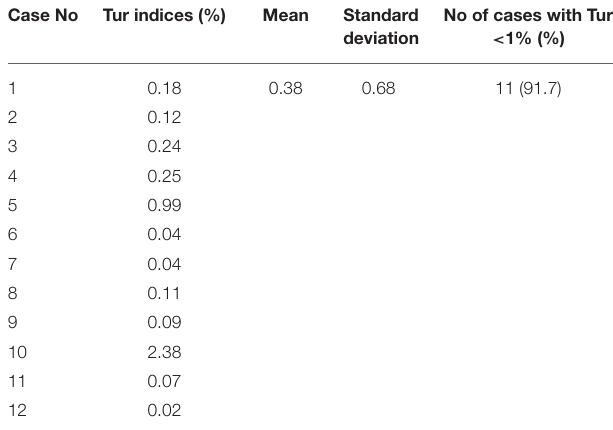
TABLE 1 | Baseline Tur indices (%) in 12 canine femoral